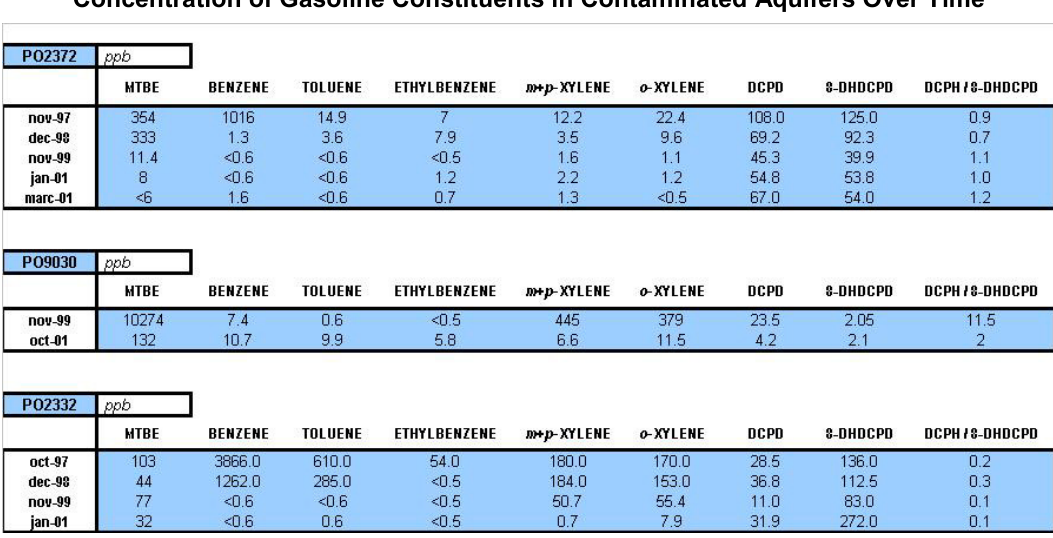
Concentration of Gasoline Constituents in Contaminated Aquifers Over